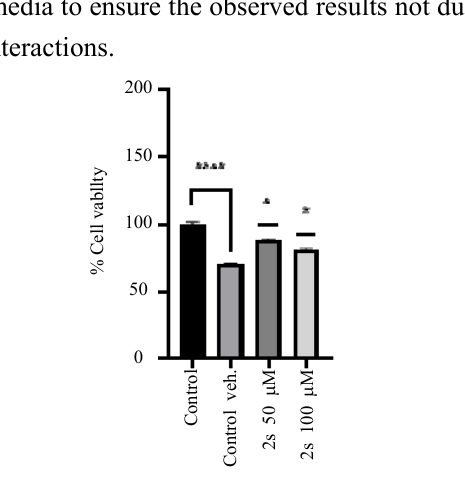
Fig. 7 Toxicity test of the ThiAKS Green at 50 µM and significant differences. Data mean ±SEM experiment performed triplicate